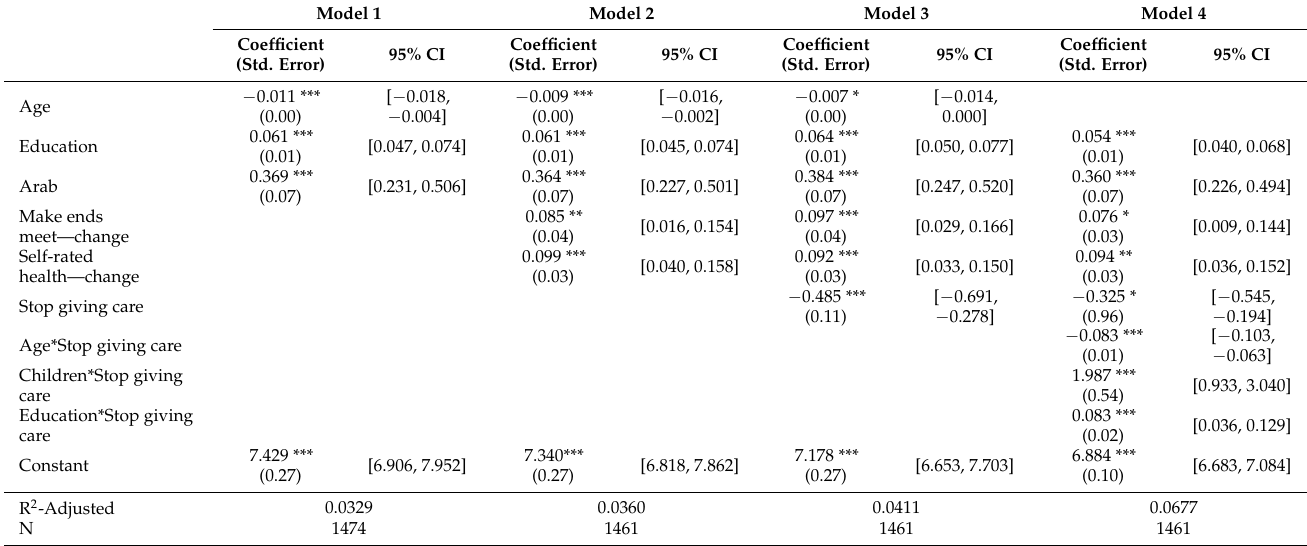
Table 5. Linear regression analysis with life satisfaction as a dependent